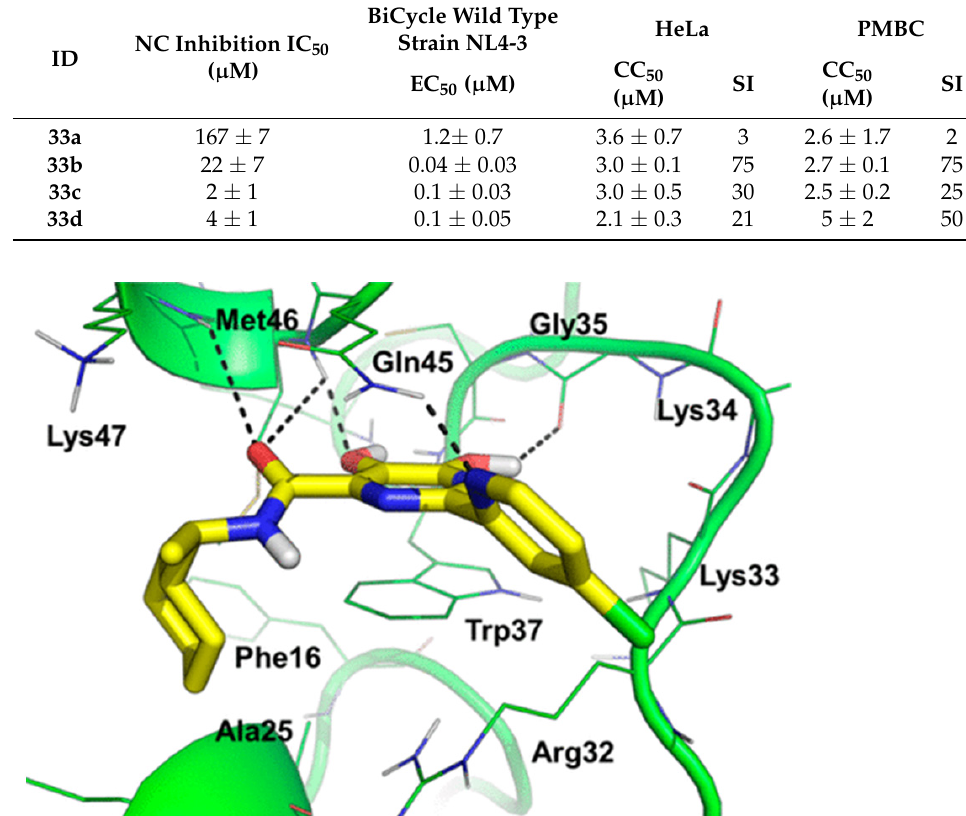
Figure 6. The molecular interaction of 33c in the HIV nucleocapsid [38]. Table 5. The inhibiting activity of analogs 33 against HIV nucleocapsid and cells [38].